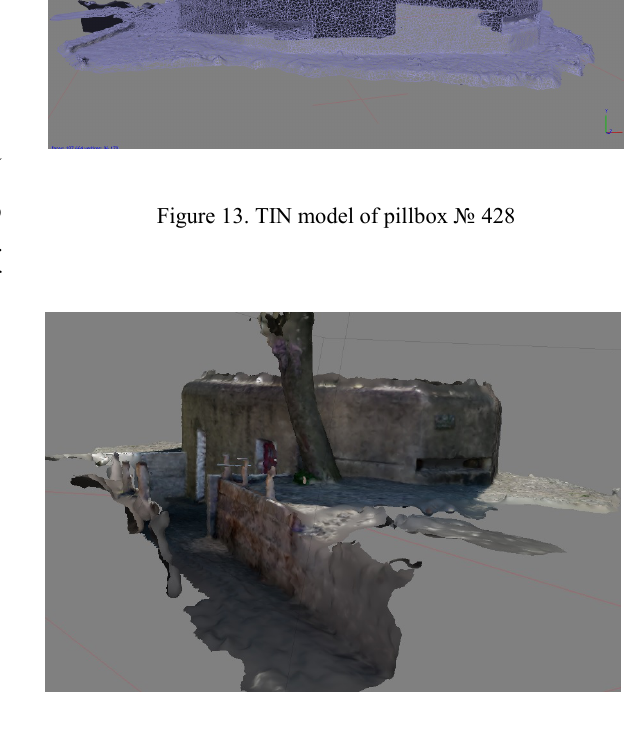
Figure 14. 3D model of pillbox № 428 with